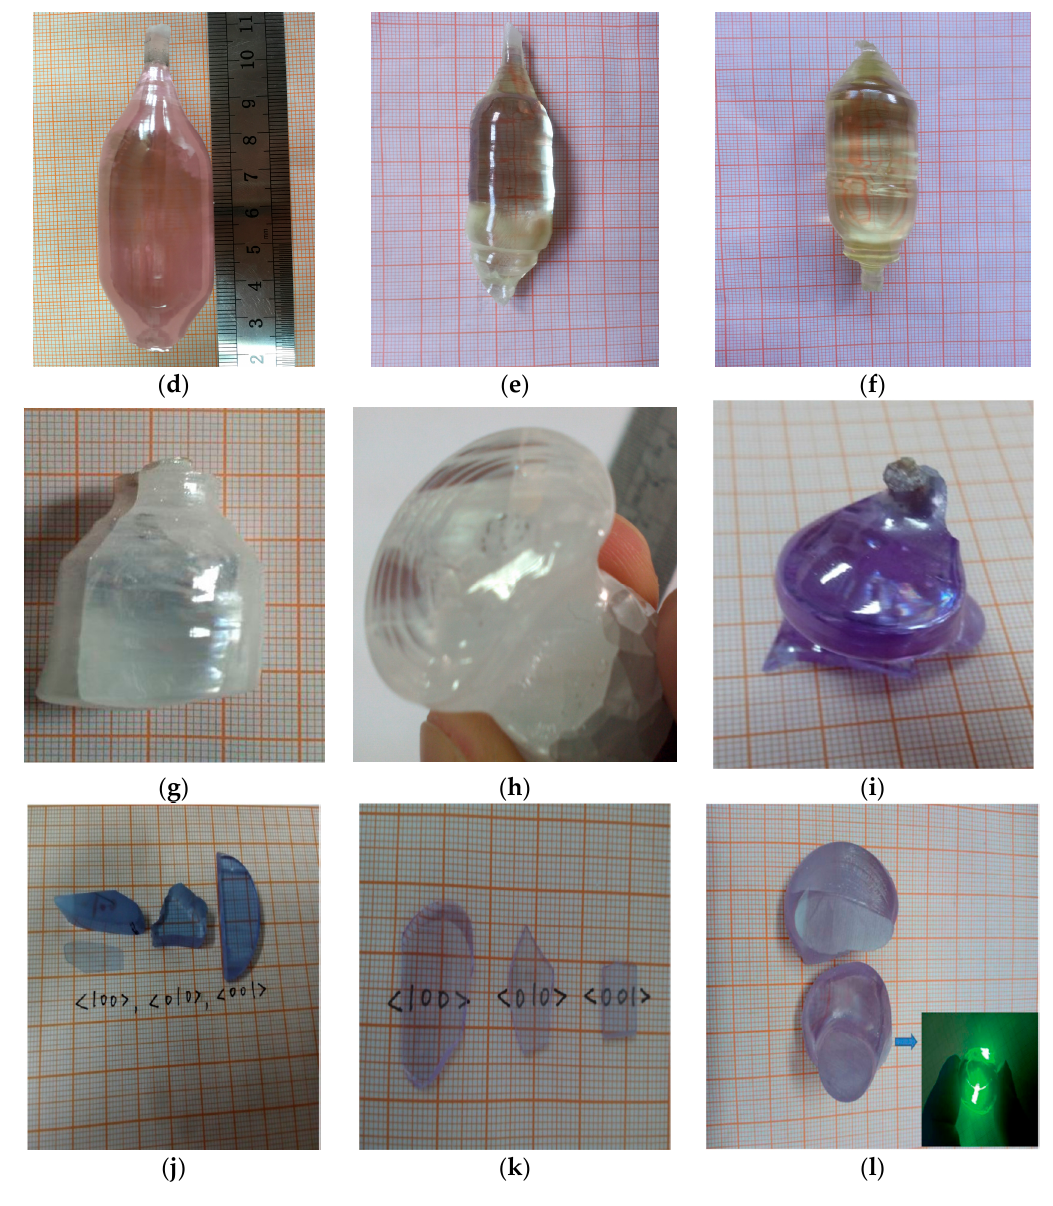
Figure 1. Photographs of the as-grown crystals: ( a ) GdTaO 4 ; ( b ) Nd:GdTaO 4 ; ( c ) Nd:GdYTaO 4 ; ( d ) Er:GdTaO 4 ; ( e ) Tm,Ho:GdYTaO 4 ; ( f ) Yb,Ho:GdYTaO 4 ; ( g ) Yb:GdNbO 4 ; ( h ) Yb:YNbO 4 ; ( i ) Nd:GdNbO 4 ; ( j ) Nd:YNbO 4 ; ( k ) Nd:GdYNbO 4 ; and ( l ) Nd:GdLaNbO 4.